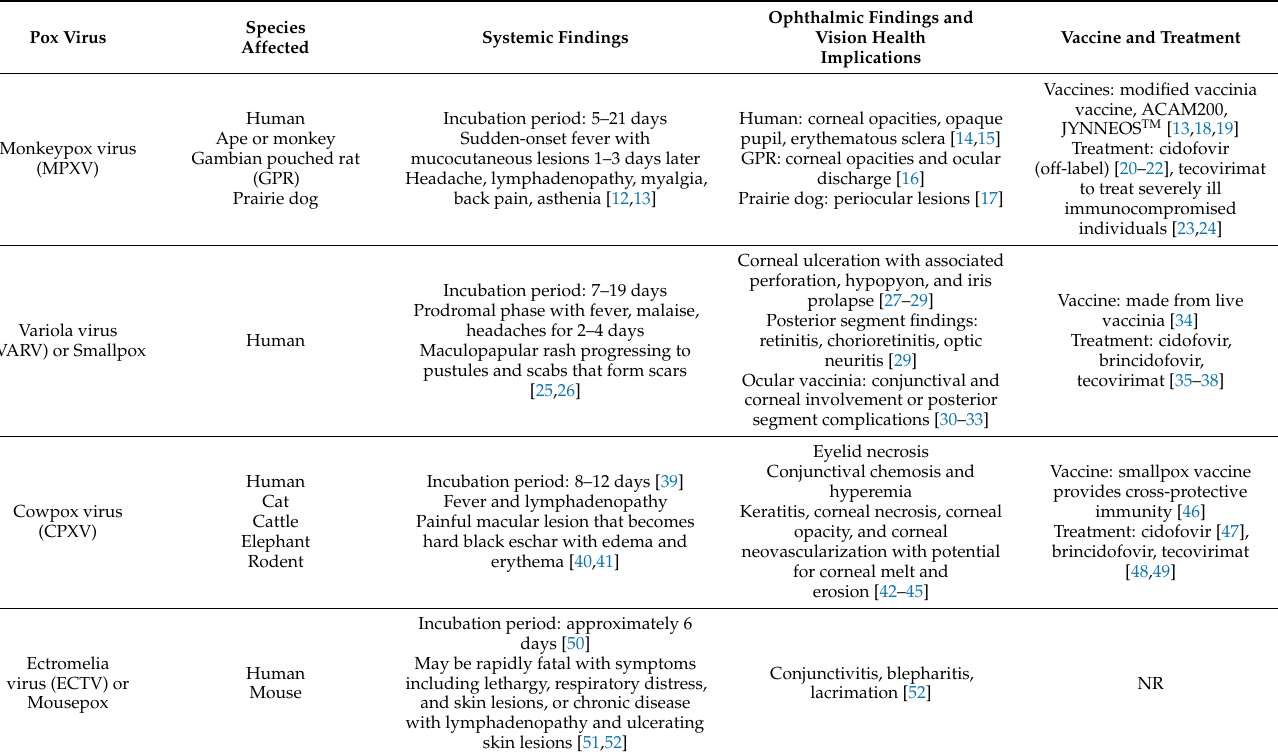
Table 1. Summary of orthopoxvirus diseases with systemic and ophthalmic findings of clinical